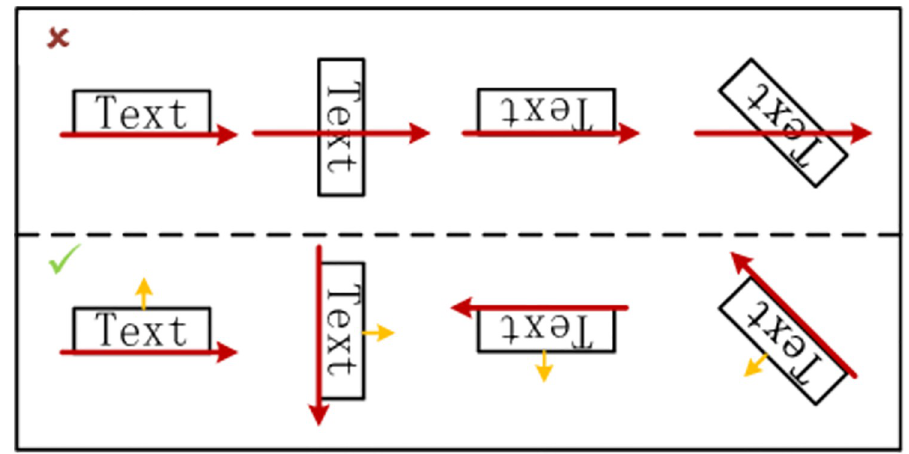
Fig 6. Comparison of two different link